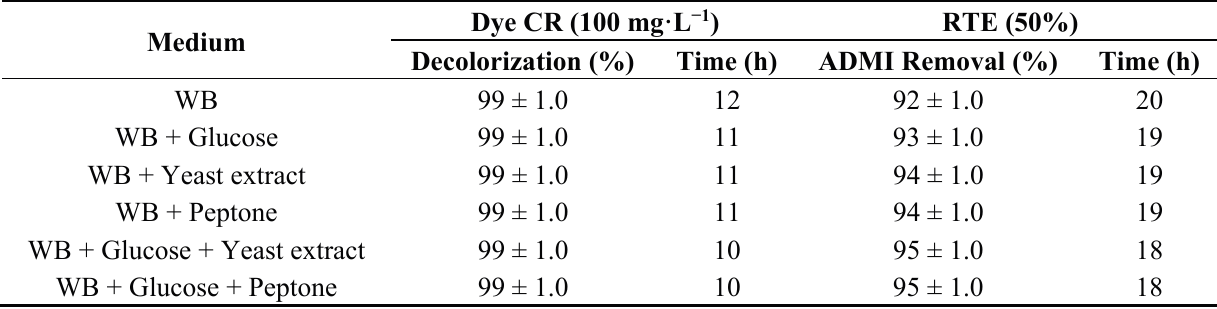
Table 1. Effect of additional carbon and nitrogen sources on the decolorization of dye CR and RTE by PUF immobilized microbial